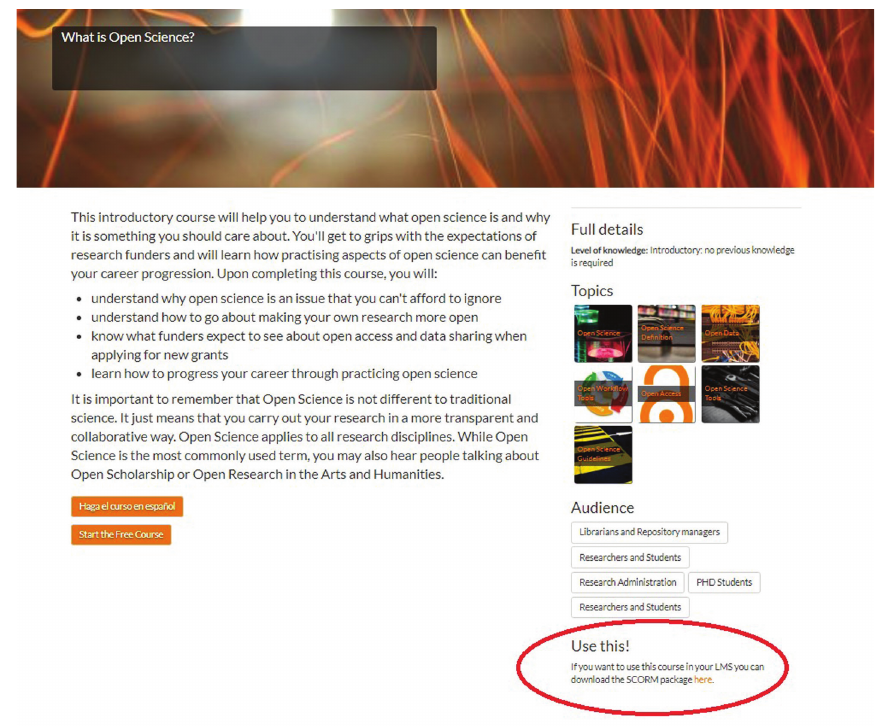
Fig. 5: Download toolkit courses into SCORM.